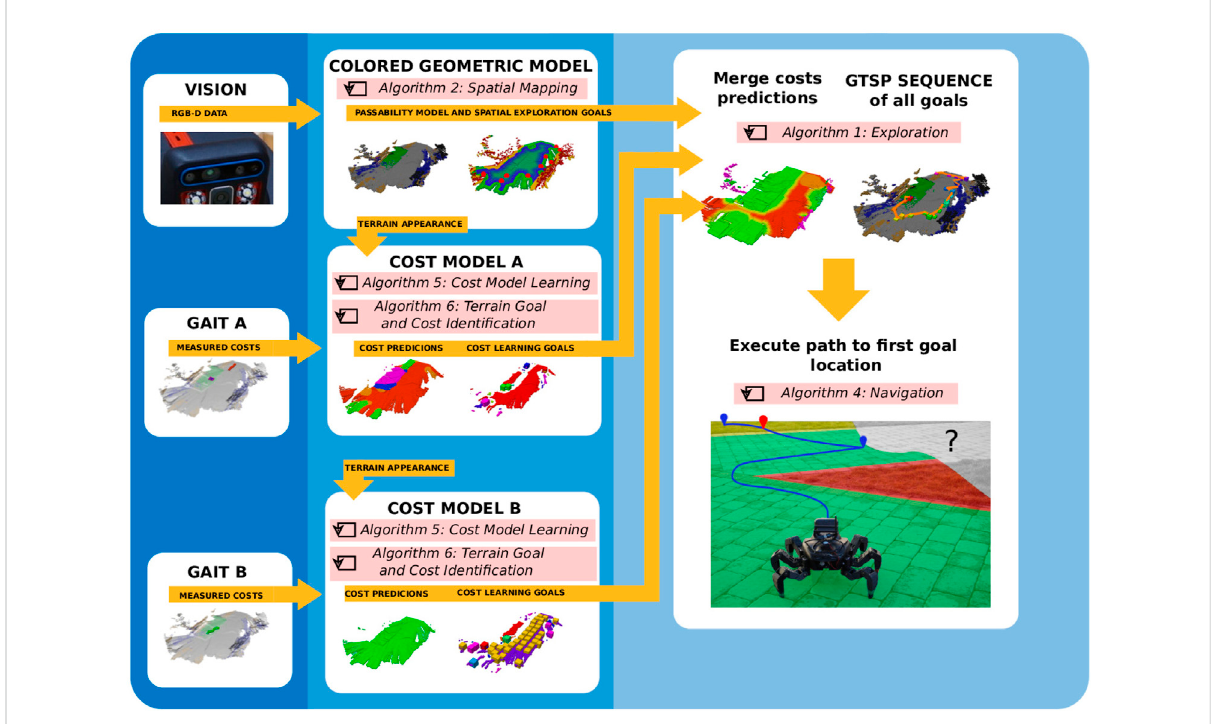
FIGURE 3 Anoverviewoftheproposedexplorationsystem.TherobotusestheRGB-Ddatatobuildthecolorelevationmodeloftheenvironmentinwhich itidenti fi esthepassableareas(Algorithm2).Theterrainappearancestoredinthemodelispairedwiththecostsexperiencedbytherobottolearnthe traversal cost models for the individual locomotion gaits (Algorithm 5 and Algorithm 6). The cost predictions for the individual gaits and the